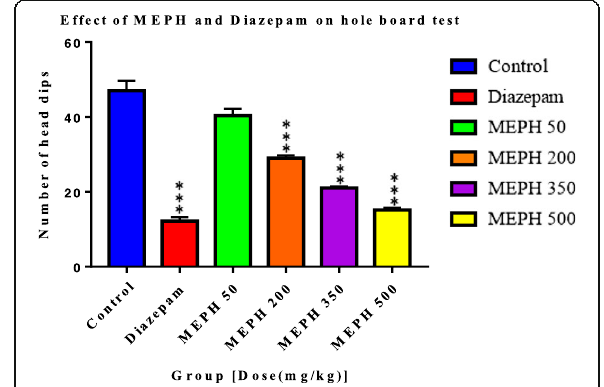
Fig. 8 The effect of MEPH on marble burying test (number of marble burying) in mice